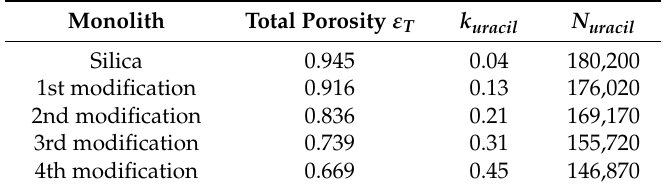
Table 1. The total porosity, retention factors, and efficiency of prepared monolithic columns. Monolith